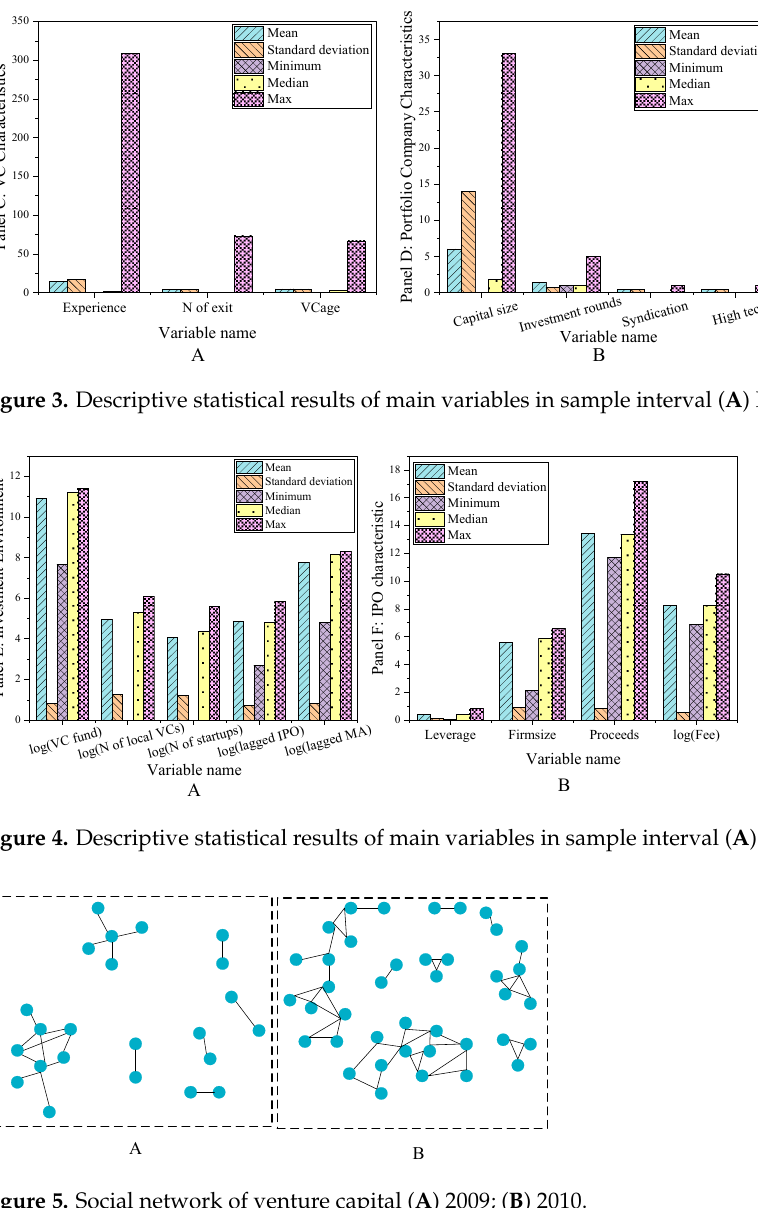
Figure 5. Social network of venture capital ( A ) 2009; ( B )